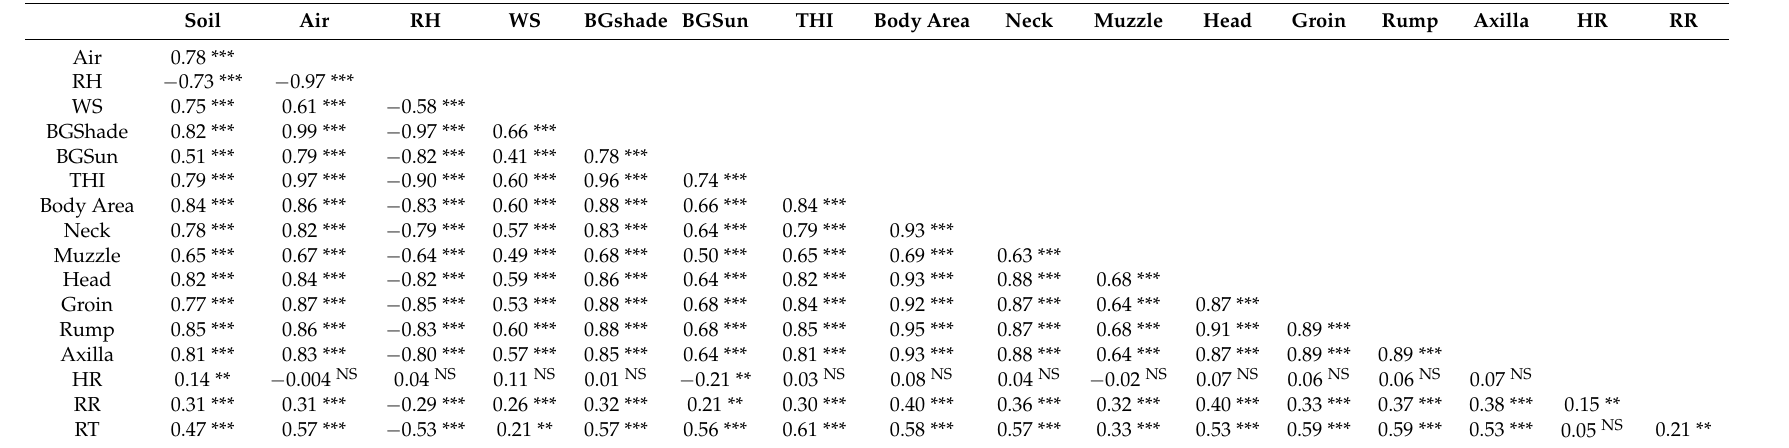
Table 3. Correlations between superficial temperatures and physiological traits of the